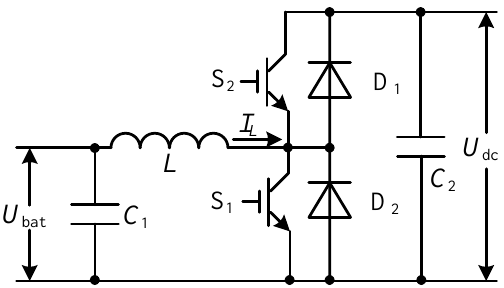
Figure 4. Working principle of ESU and DC–DC converter.